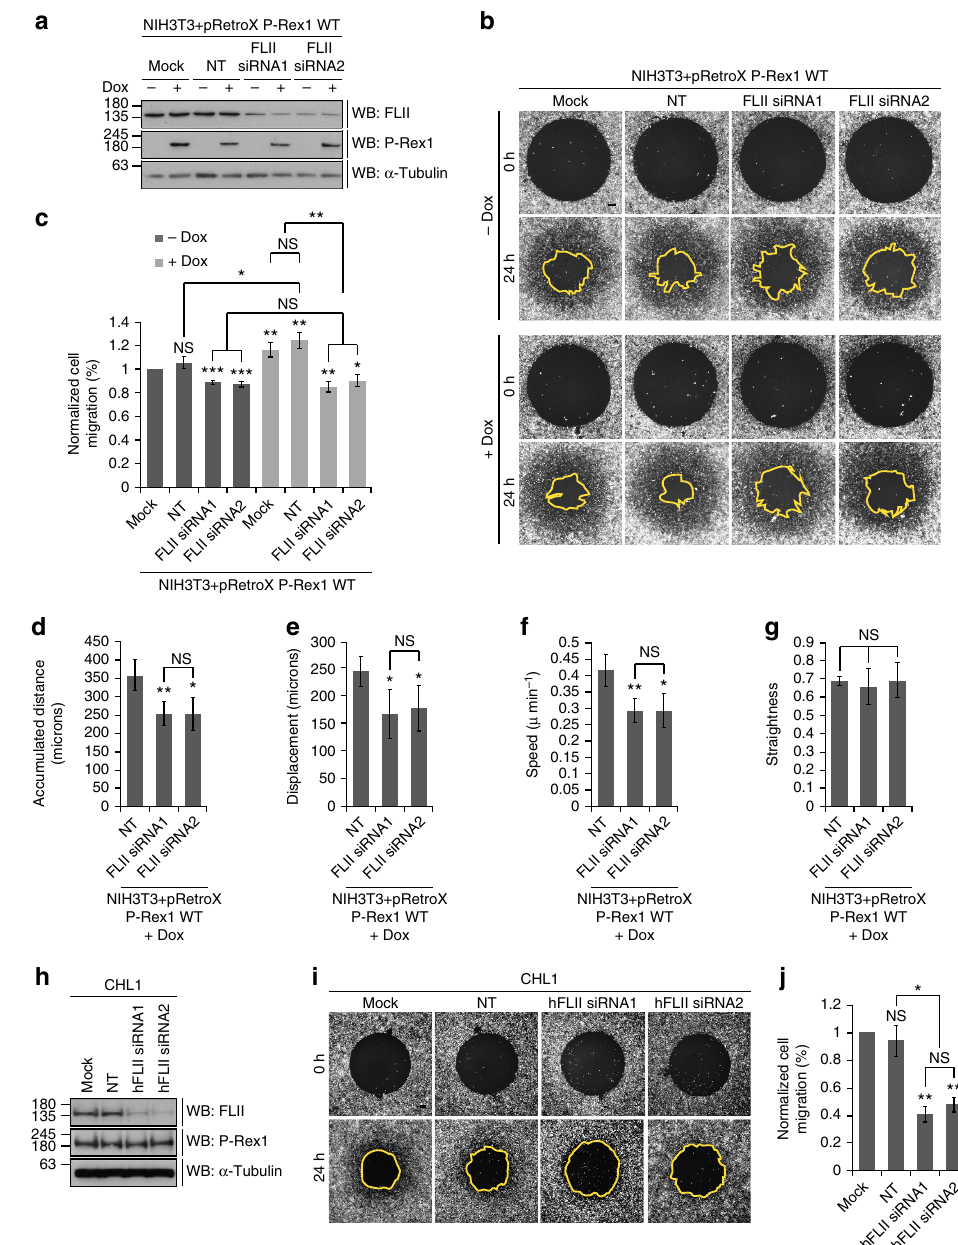
Figure 6 | FLII is required for P-Rex1-Rac1-driven cell migration. ( a ) Western blot of NIH3T3 cells (NIH3T3 þ pRetroX P-Rex1 WT) treated with mock, NT or two different siRNAs against FLII (FLII siRNA1 and FLII siRNA2) in the presence of ethanol ( (cid:2) dox) or 1 m gml (cid:2) 1 doxycycline ( þ dox) to induce expression of P-Rex1 WT. Levels of endogenous FLII and P-Rex1 expression were detected by western blot analysis. ( b ) Representative fluorescence images following Oris migration assay of cells described in a . Scale bar, 200 m m. ( c ) Quantification of cell migration of NIH3T3 cells described in a normalized to (cid:2) dox treated mock cells. ( d – g ) Single-cell tracking of NIH3T3 cells expressing P-Rex1 WT following dox induction and treatment with indicated oligos. Graphs show the effect of FLII knockdown on ( d ) accumulated distance, ( e ) displacement, ( f ) speed and ( g ) straightness. ( h ) Western blot of CHL1 cells transfected with NToligo or two different siRNAs against human FLII (hFLII siRNA1 and hFLII siRNA2). Levels of endogenous FLII were detected by western blot analysis. In a , h a -Tubulin was used as a loading control. Representative western blots from three independent experiments. ( i ) Representative fluorescence images following Oris migration assay of CHL1 cells treated with indicated oligos. Scale bar, 200 m m. ( j ) Quantification of cell migration of CHL1 cells described in h normalized to mock treated cells. For c , j graphs represent the average per cent migration ± s.e.m. from three independent experiments. For c – g , j , Student’s t -test was used to assess significance as indicated on graphs. P values indicated above each bar are relative to (cid:2) dox treated mock cells ( c ), or NT control ( d – g ) or mock treated cells ( j ). NS ¼ non-significant; * ¼ P r 0.05; ** ¼ P r 0.01; *** ¼ P r only fibroblast-collagen matrices prepared using P-Rex1 WT second harmonic generation (SHG) imaging, respectively expressing 1 (cid:2) human fibroblasts exhibited increased collagen (Fig. 7e,f and Supplementary Fig. 7f,g). Additionally, we content and crosslinking as indicated by picrosirius staining and utilized gray-level co-occurrence matrix (GLCM) analysis 61 on